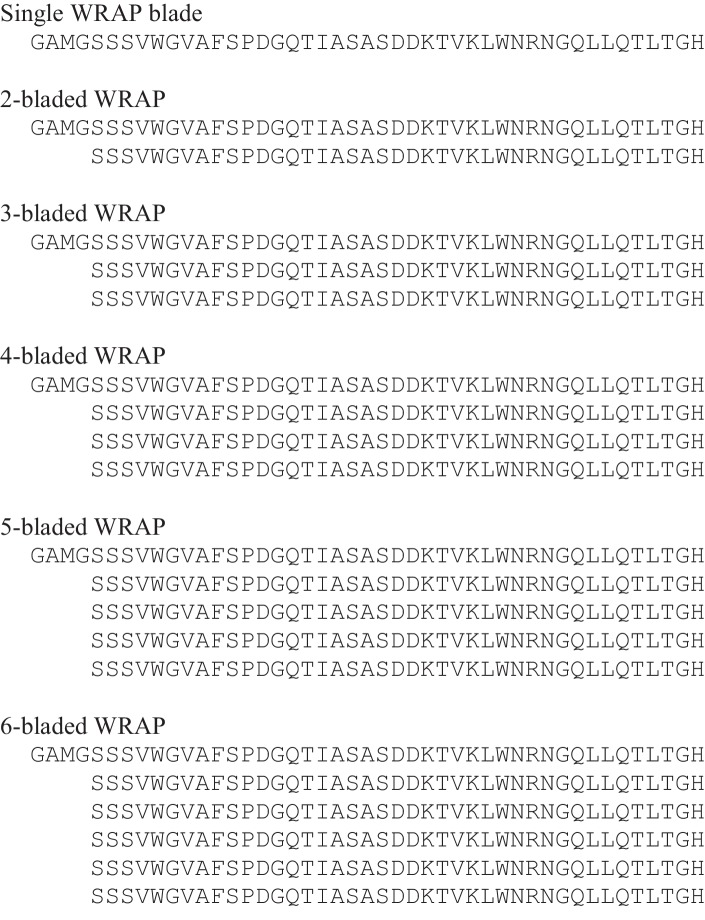
Sequences of WRAP constructs.All constructs start with an additional GAMG after TEV-cleavage.